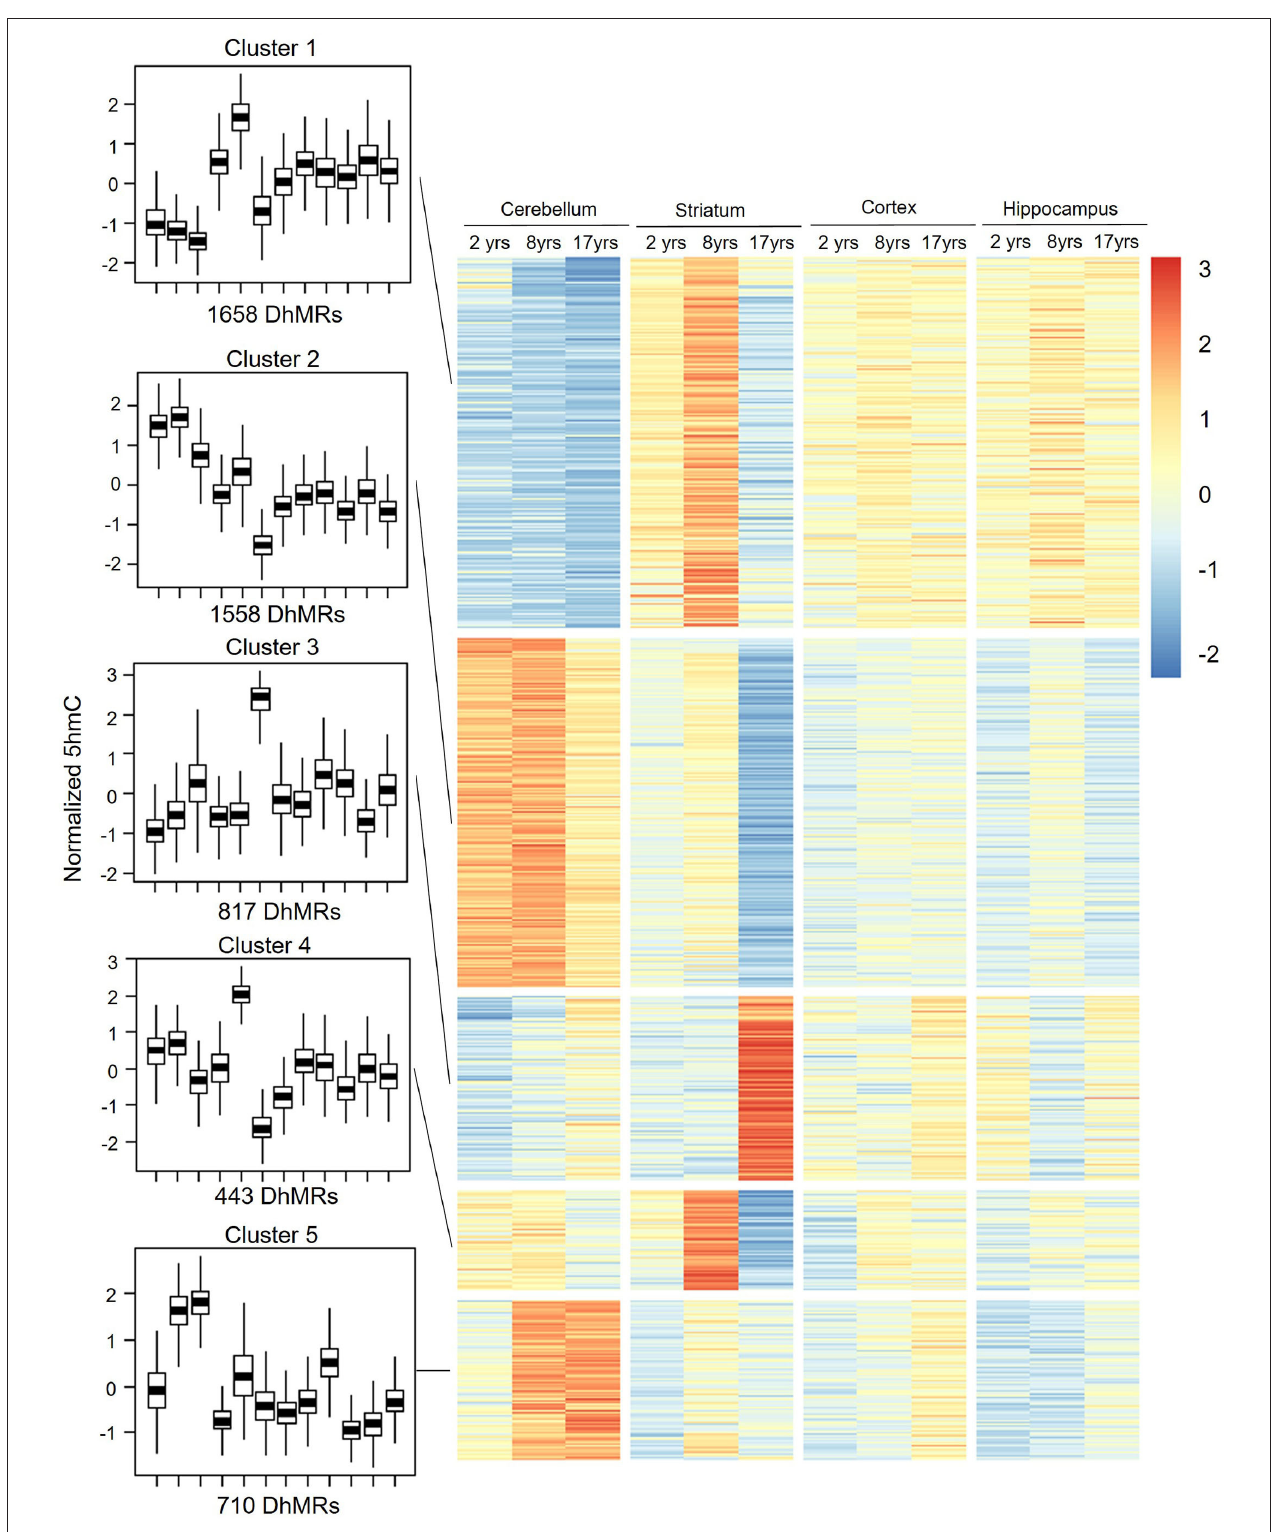
FIGURE 4 | DhMRs clustering. Five clusters were grouped according to significant differences, which consist of 1,658 DhMRs in Cluster 1, 1,558 DhMRs in Cluster 2, 817 DhMRs in Cluster 3, 433 DhMRs in Cluster 4, and 710 DhMRs in Cluster 5.